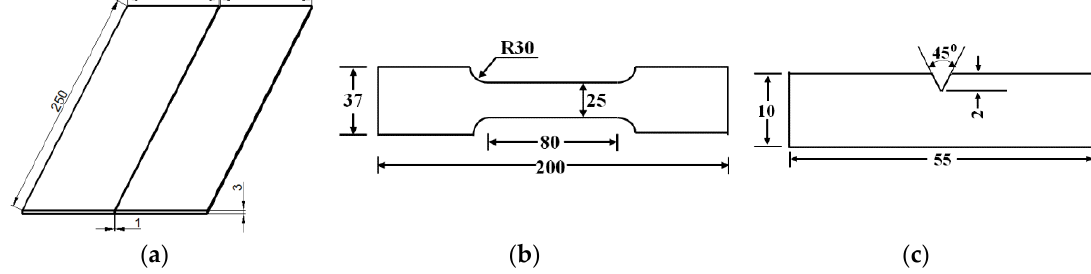
Figure 2. Dimensions of test specimens (unit: mm): ( a ) Draft of plate and all dimensions, ( b ) Specimen for tensile test, ( c ) Specimen for Charpy impact test.